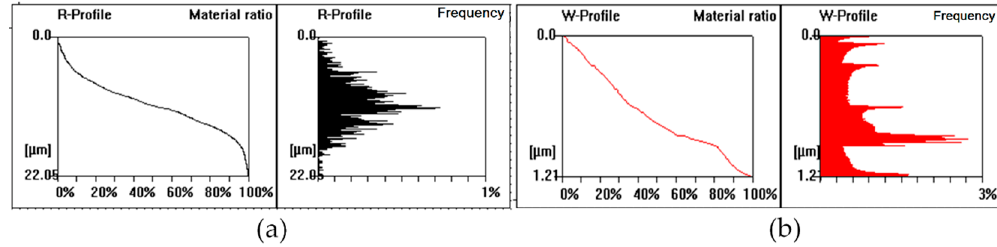
Figure 10. The material ratio curves and frequency density curves for the profiles measured in parallel direction to the wire feed: ( a )—for the roughness, ( b )—for the waviness.